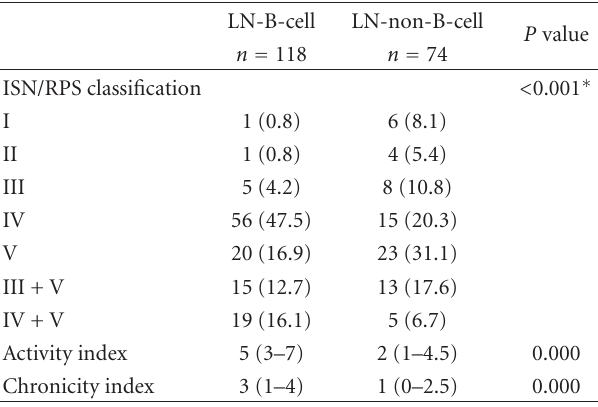
Table 1: Demographics, clinical characteristics, and laboratory analysis of LN patients.